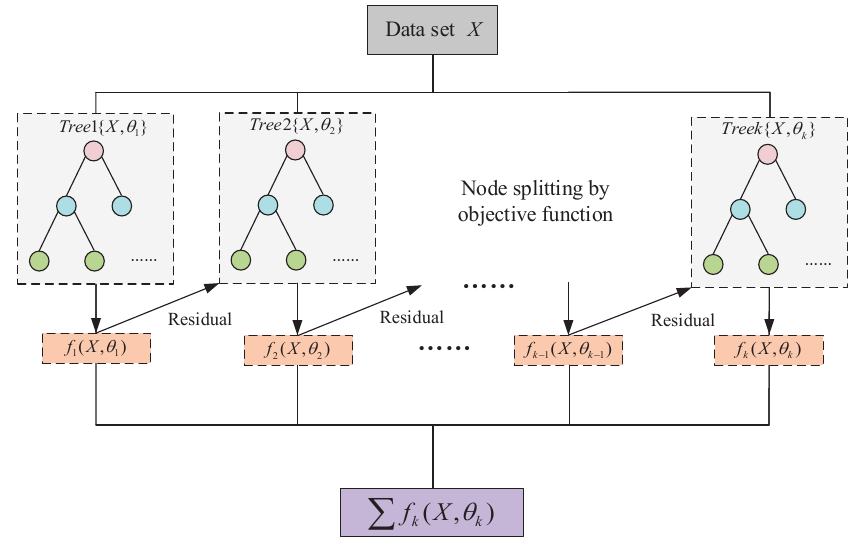
Figure 3. Flow chart of XGBoost.